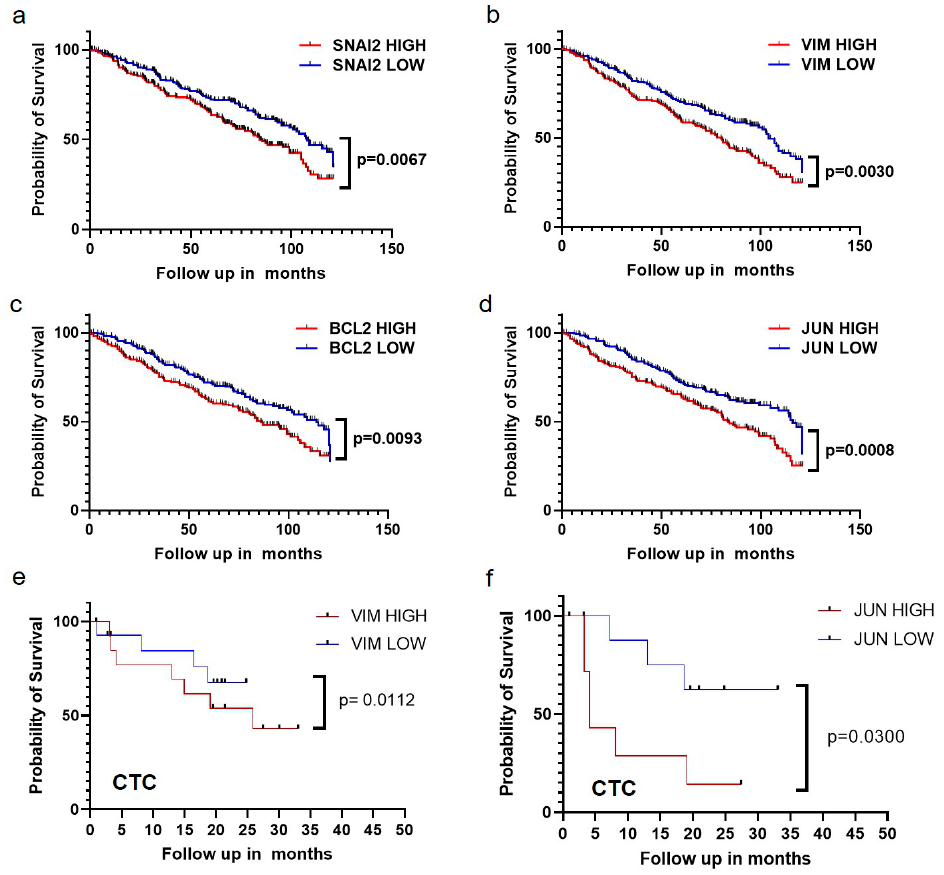
Figure 6. The expressions of EMT genes, Bcl-2, and JUN gene are correlated with poor diagnosis and survival of breast cancer patients. ( a – d ) Kaplan–Meier analysis of the relapse-free survival rate was based on the expression of Snail2 ( a ), vimentin ( b ), Bcl-2 ( c ), and JUN ( d ) in breast patients from GSE6532 ( n = 781), GSE3494 ( n = 315), GSE7390 ( n = 198), and GSE1456 ( n = 159) public databases. n = 1453 patients; ( e , f ) Kaplan–Meier analysis of the relapse-free survival rate was based on the expression of vimentin ( e ) and JUN gene ( f ) in the CTCs of breast patients from the GSE144494 database. n = 45 patients. The patients were split into three tertile groups in terms of gene expression. The group with high/low gene expression represented cancer patients in the highest/lowest tertile. The red and blue line represents the high and low expression of the indicated gene. The statistical analysis in the survival curves was conducted using the log–rank (Mantel–Cox) test.